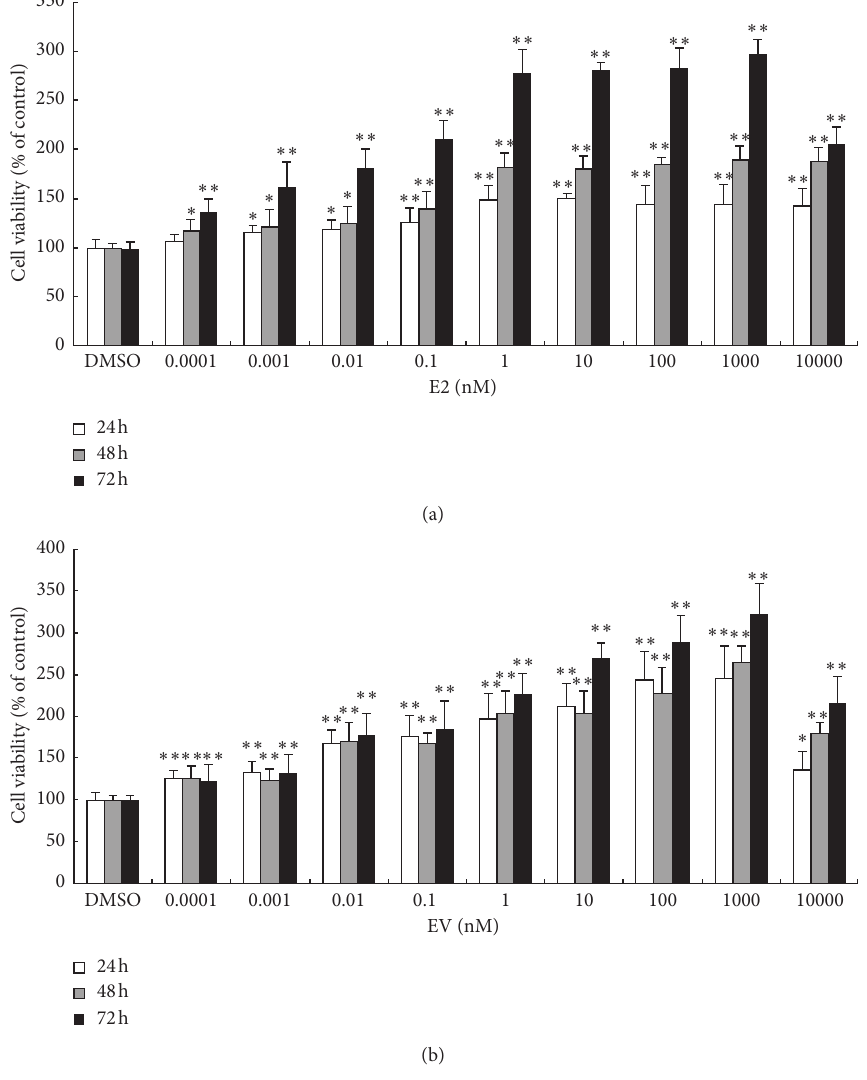
Figure 1: Effects of E2 (a) and EV (b) on the viability of MCF-7 cells. Data points represent mean ± SD of three independent experiments. Asterisks show statistically significant differences with respect to corresponding negative DMSO ( ∗ p < 0 . 05 , ∗∗ p < 0 . 01 )